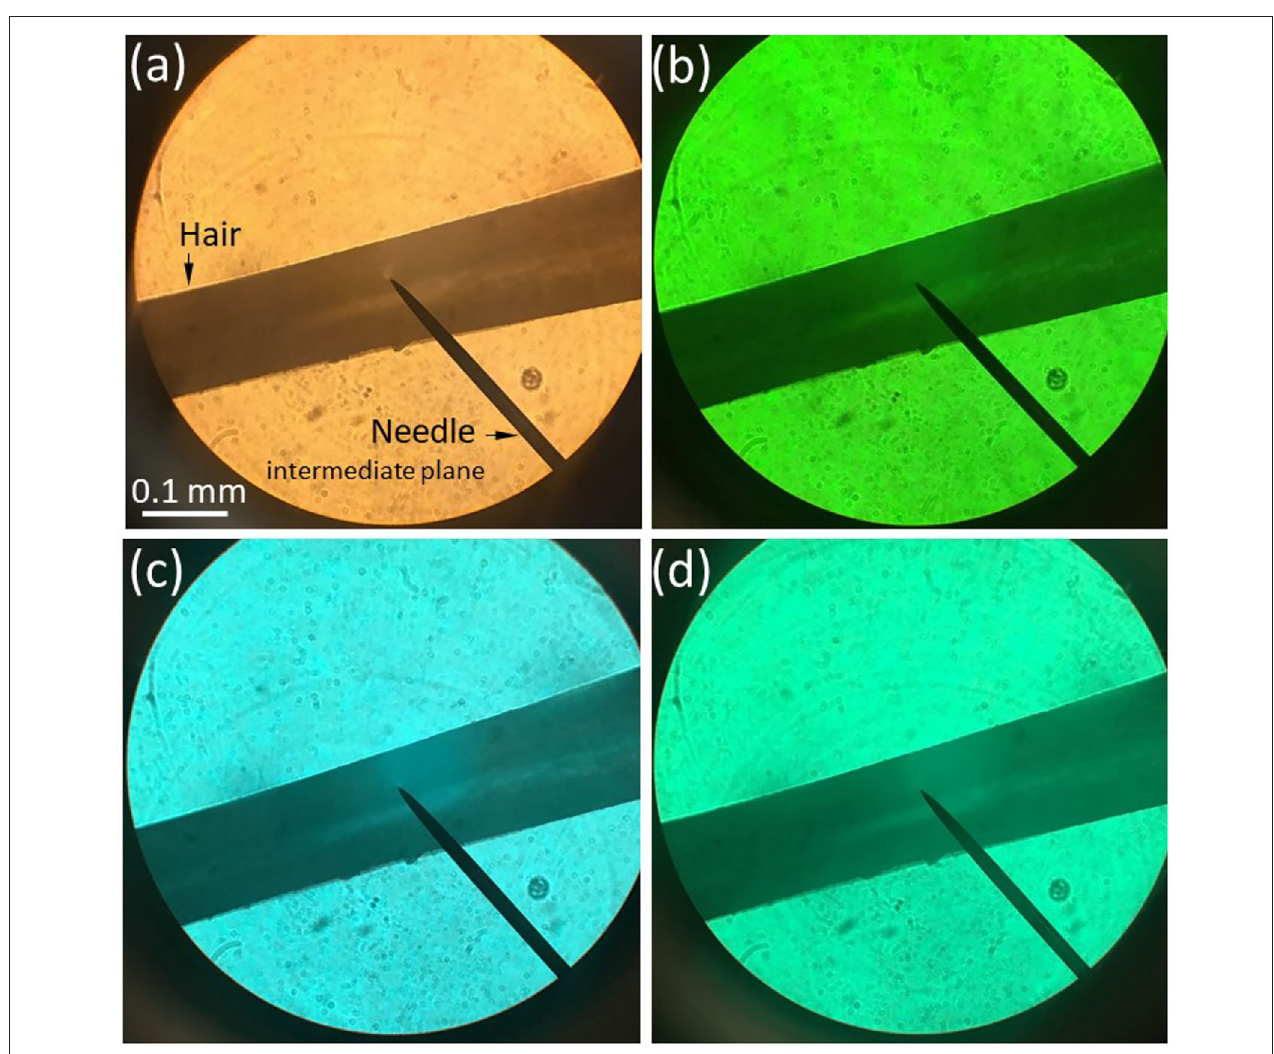
FIGURE 4 | Imaging in a conventional microscope illuminated with light output from the spectrum generator system. (a) Solar spectrum. (b) Narrowband illumination centered at 500nm. (c) Narrowband illumination centered at 475nm. (d) Lowpass illumination with cut-off centered at 550nm. masks g 500 ( x ) and g 650 ( x ) that generate the bandpass spectra with BP BP cut-off at 500 and 650 nm, respectively. Now, in each mask, the function g 1 ( x ) is used until the spatial location corresponding to the cut-off wavelength, where the mask is selected to the function g 0 ( x ) that provides the null transmission shown in Figure 2b